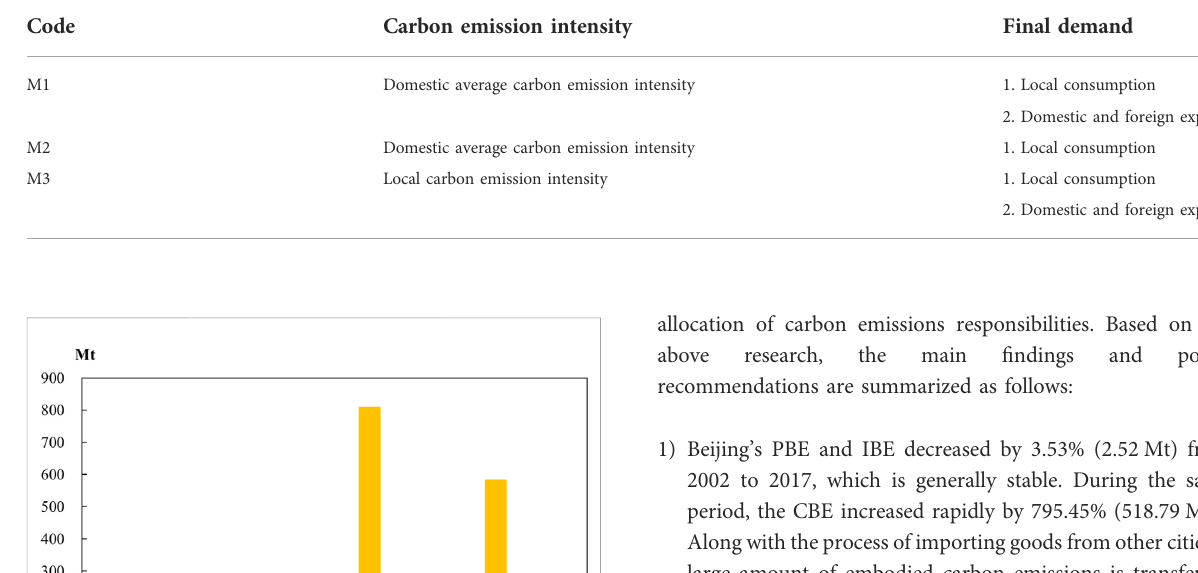
TABLE 2 Comparison of different parameter de fi nitions, consumption-based accounting method.